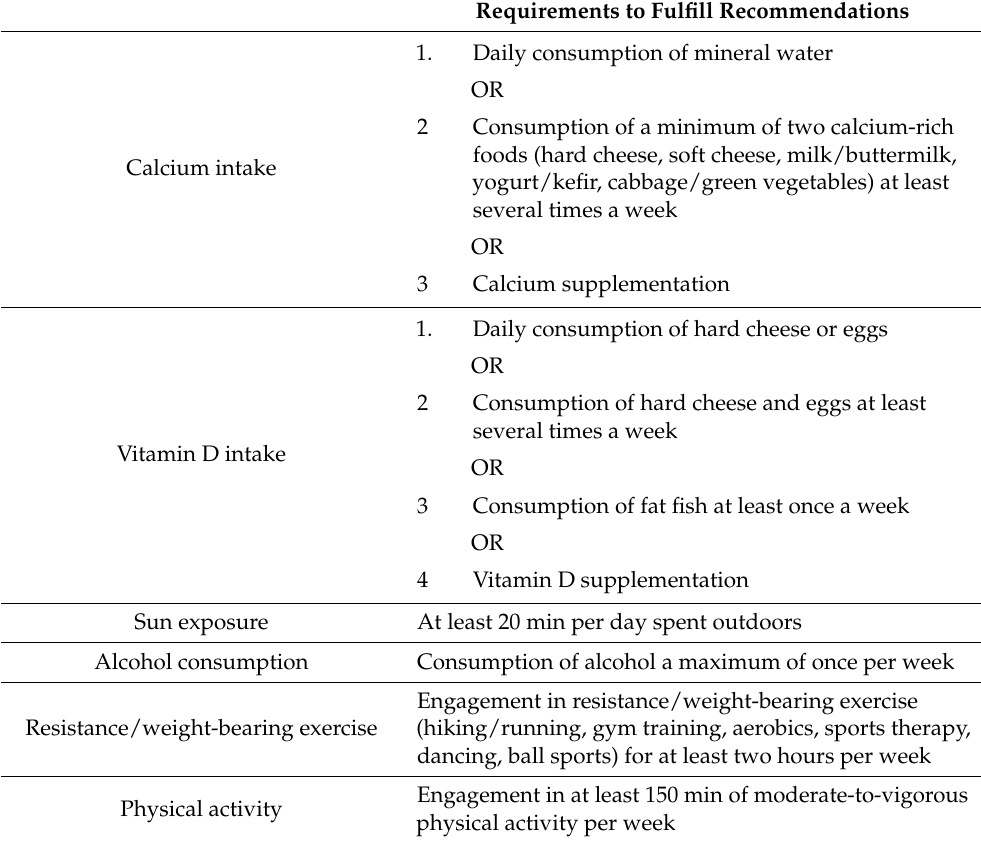
Table 1. Overview of requirements to fulfill lifestyle recommendations for bone